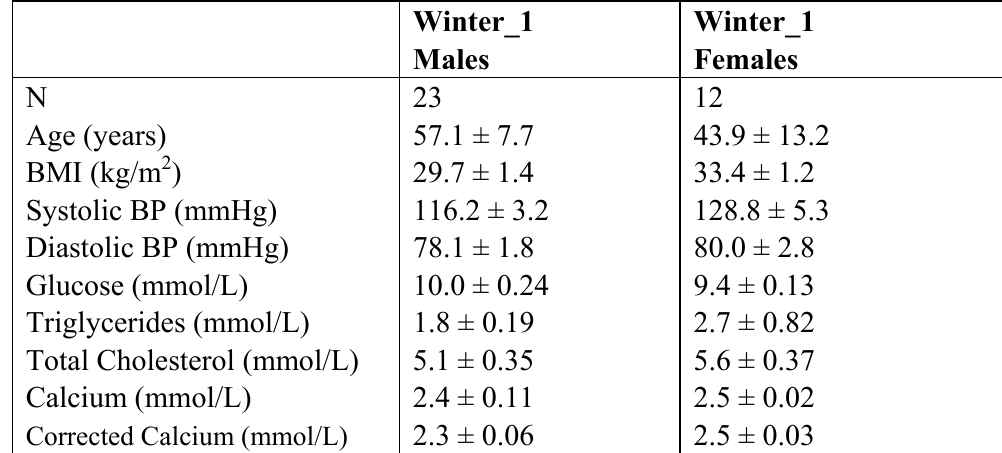
Table 1. Baseline Anthropometric and Biochemical Characteristics of Male and Female